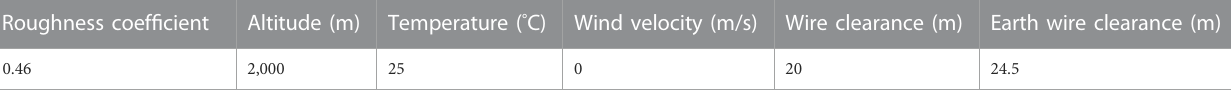
TABLE 3 Parameter settings.